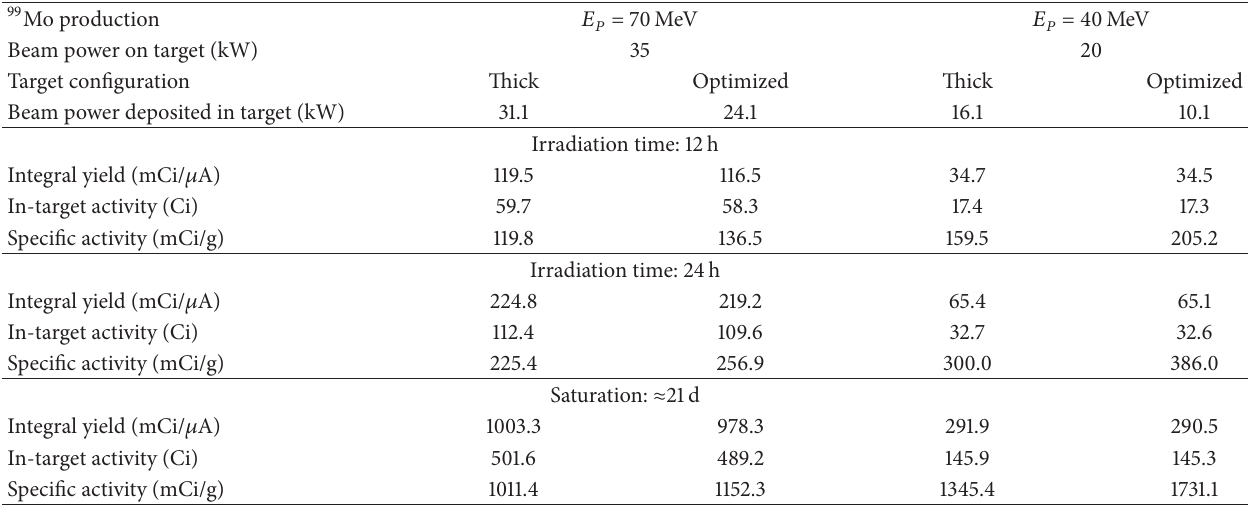
𝐸 𝑃 = 70 MeV 𝑃 = 40 MeV